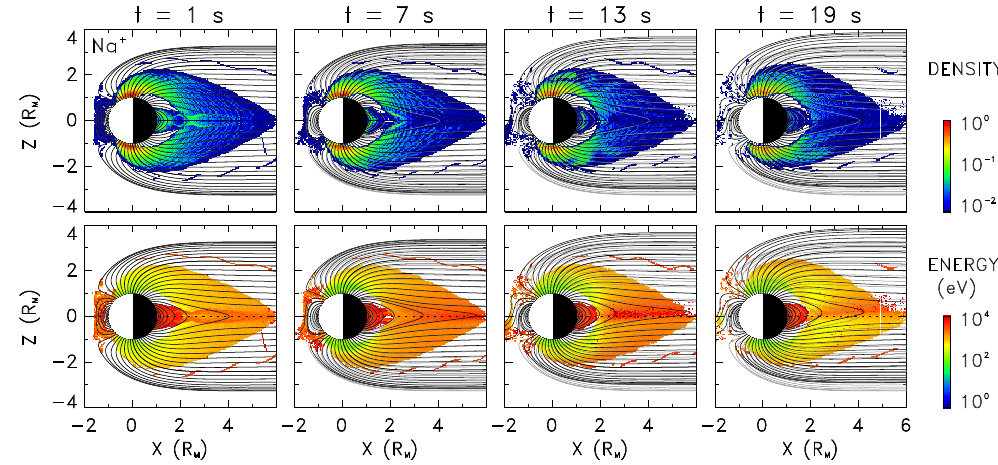
Fig. 11. (Top) Model normalized density and (bottom) average energy of Na + ions in the noon-midnight meridian plane during turning of the IMF (from B X = 0 to B X = 20nT in 20s). The ions are launched from the high-latitude dayside sector (see text). The panels from left to right show snapshots at distinct times of the magnetic transition. Black and grey lines show the magnetic field lines at the corresponding time and in the initial configuration, respectively. Density and energy are coded according to the color scales at right.